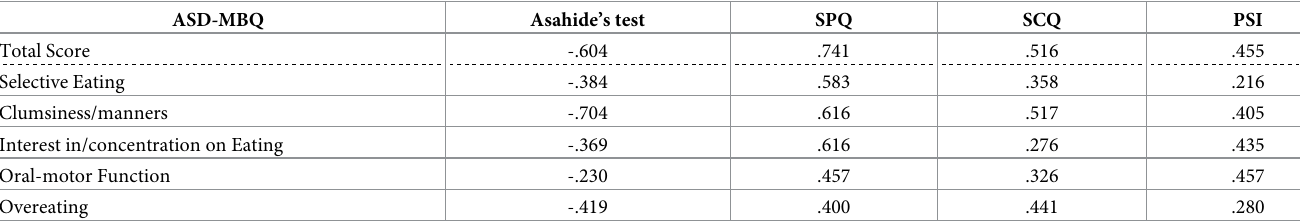
Table 3. Spearman’s correlation coefficients of the ASD-MBQ and four